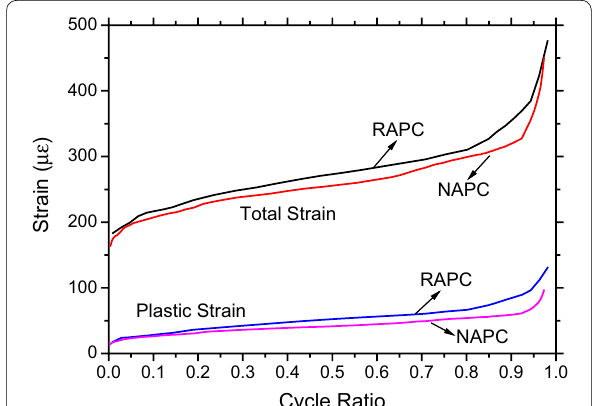
Fig. 8 Variations curves of total strain and plastic strain at stress level of 0.8.